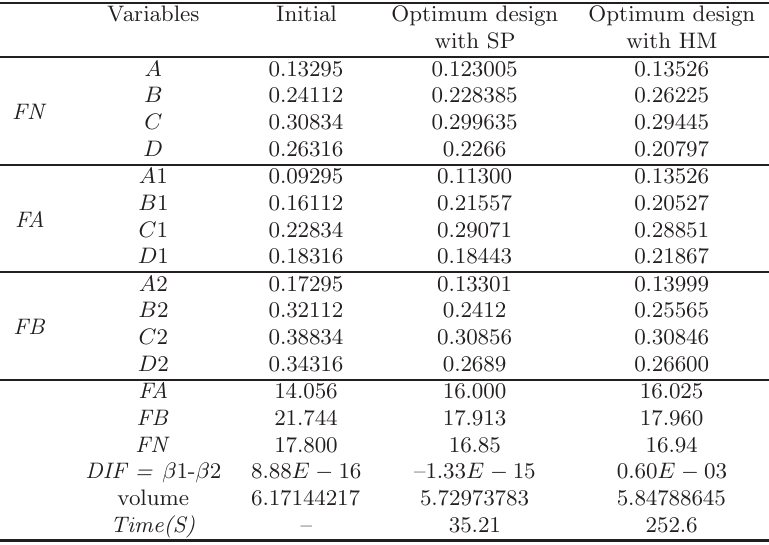
Table 7. Results for the aircraft